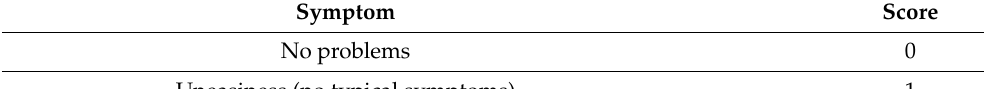
Table 1. MIsery SCale (MISC) included in the questionnaire for evaluating the motion sickness state of the participants in our experiment.